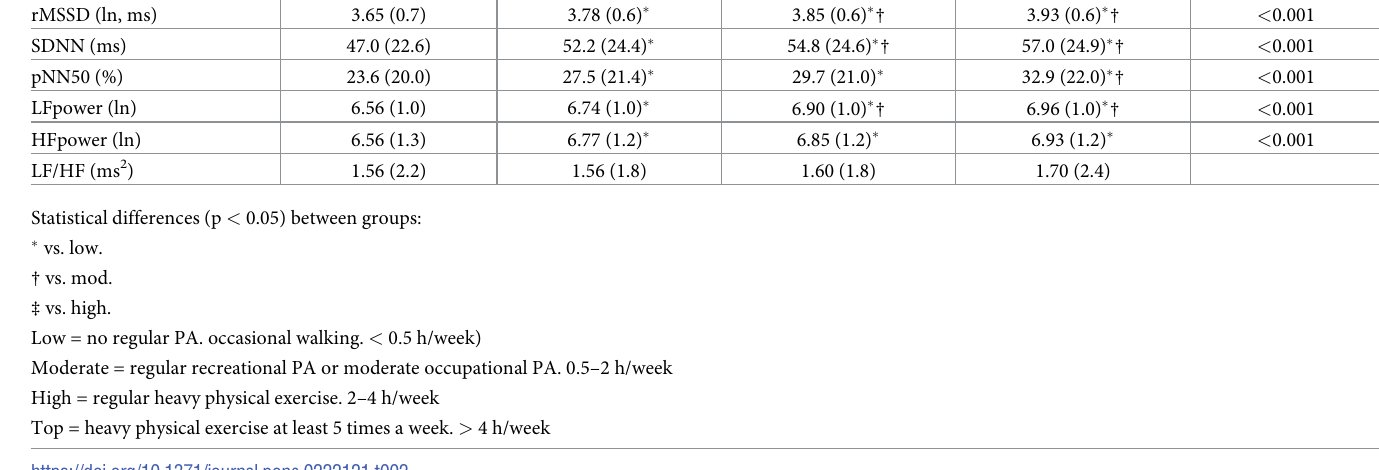
Our study provides reference values for HRV measures in the time and frequency domains in a large cohort of adolescent men. The closest comparable study involving adolescent boys (12–17 yrs.) demonstrate similar baseline results for rMSSD, SDNN and LF and HF power [20]. We detected a negative association between obesity factors (waist circumference, fat per- centage, BMI) and vagal activity (ln rMSSD), which is consistent with findings obtained from